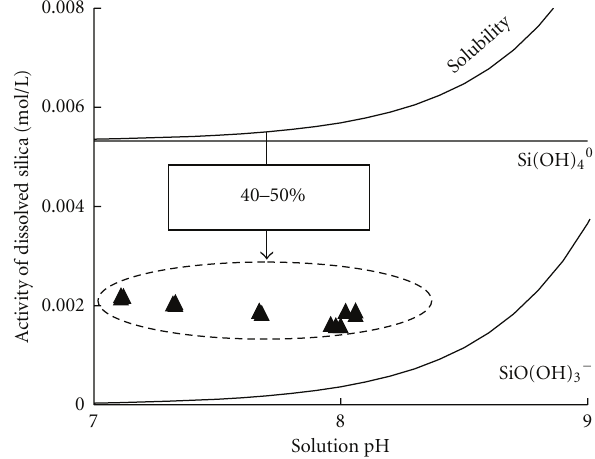
Figure 7: A thermodynamic diagram for monomeric aqueous species in equilibrium with SiO 2 (am) as a function of pH at 90 ◦ C. The solid triangles represent the concentrations of dissolved Si in the leachates for MgCl 2 solution at 90 ◦